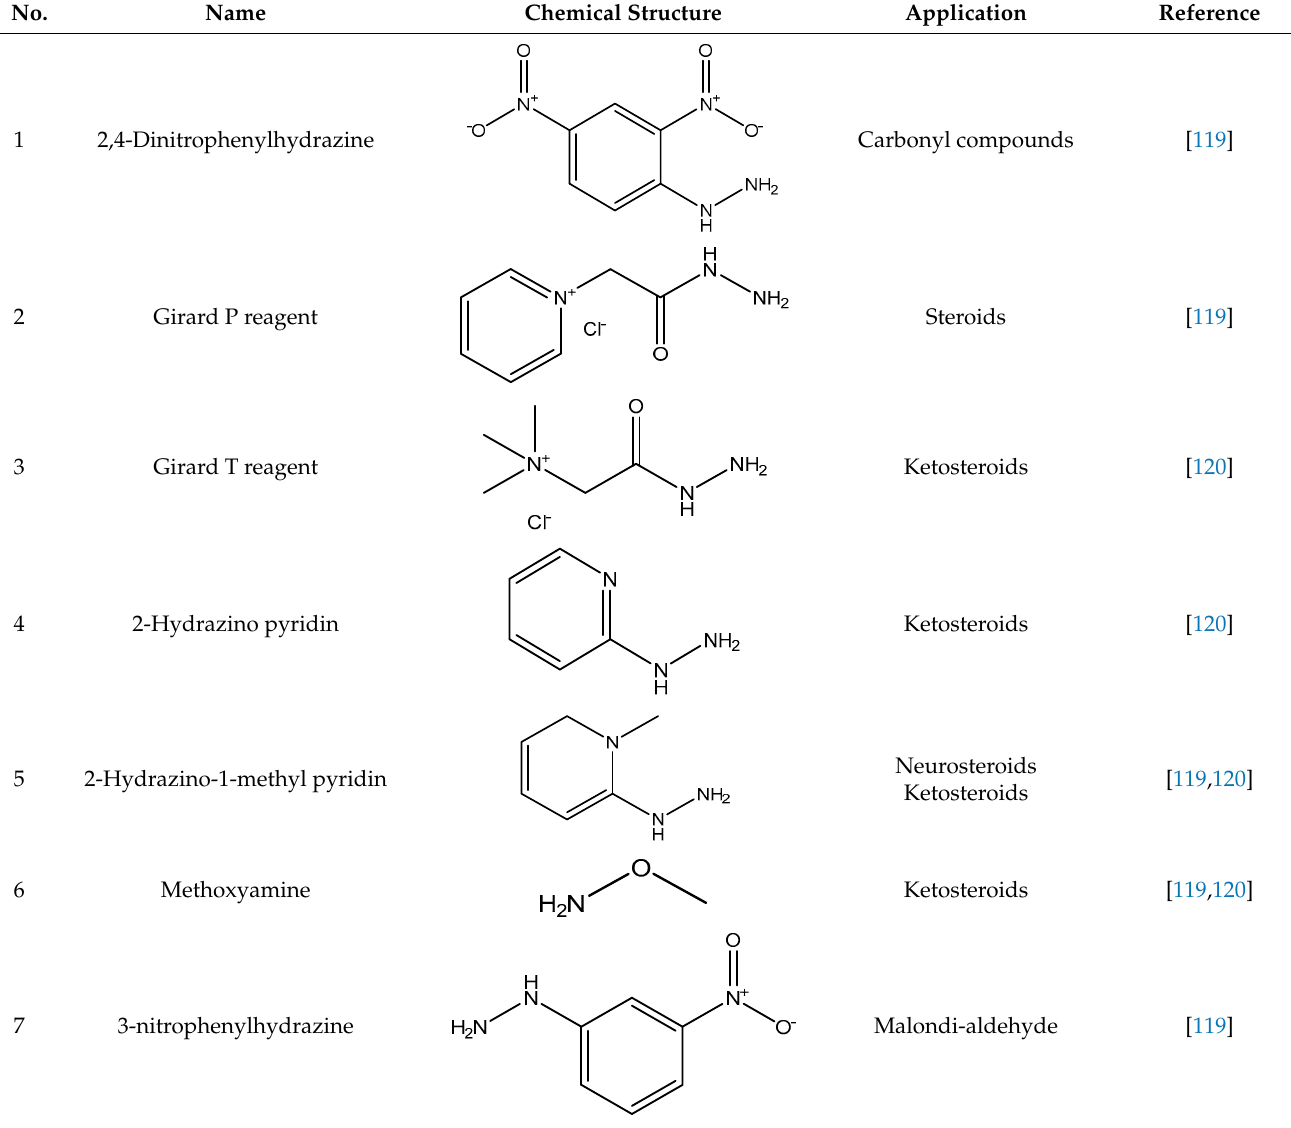
Table 4. Derivatizing reagents, their structure and targets.